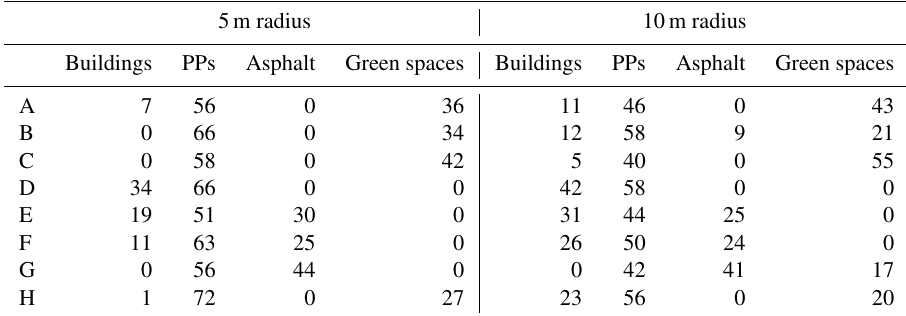
Table A1. Fraction (%) of different urban structures in the surrounding of each cluster.